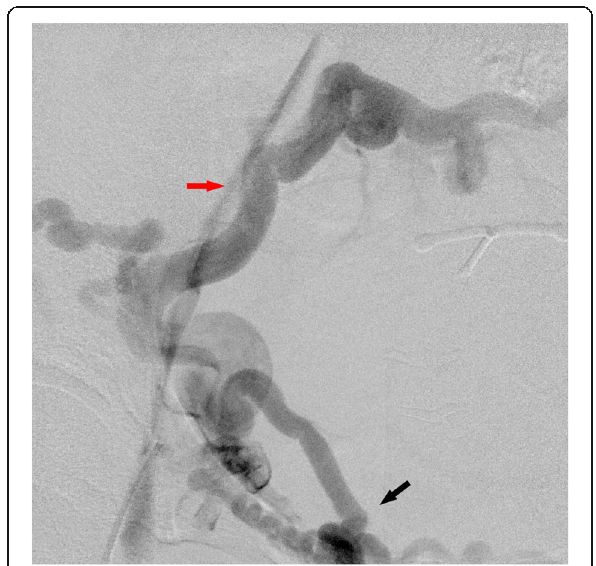
Fig. 5 Digital subtraction venography demonstrates near total occlusion of left iliac vein. Near total occlusion of the left iliac vein (red arrow). Dominant drainage is observed through a left-to-right sapheno-saphenous collaterals (black